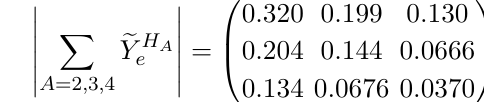
Figure 2 . Correlation between our predictions of BR( µ → 3 e ) and BR( τ → 3 e ). We set m H = 170 TeV for the plot. The red points satisfy the UTfit result of C (cid:15) do not satisfy it. The green dashed line corresponds to the future prospect [96]. The right-upper cyan star is the benchmark point for eq.